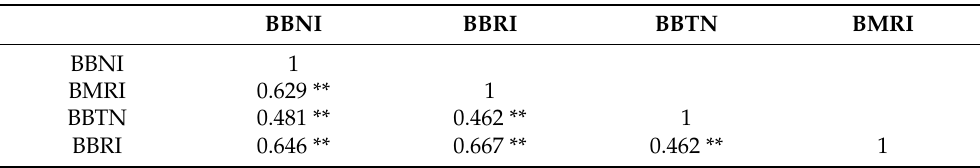
Table 2. Correlation of SOE stock returns in banking sector listed on the Indonesia Stock Exchange.